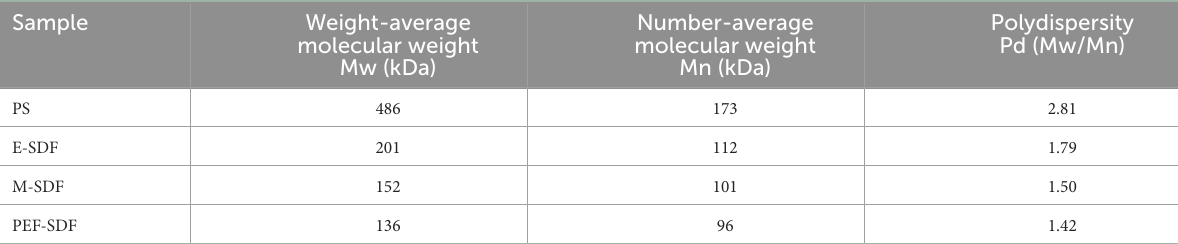
TABLE 5 The effects of PS, E-SDF, W-SDF, and PEF-SDF on molecular weight 1